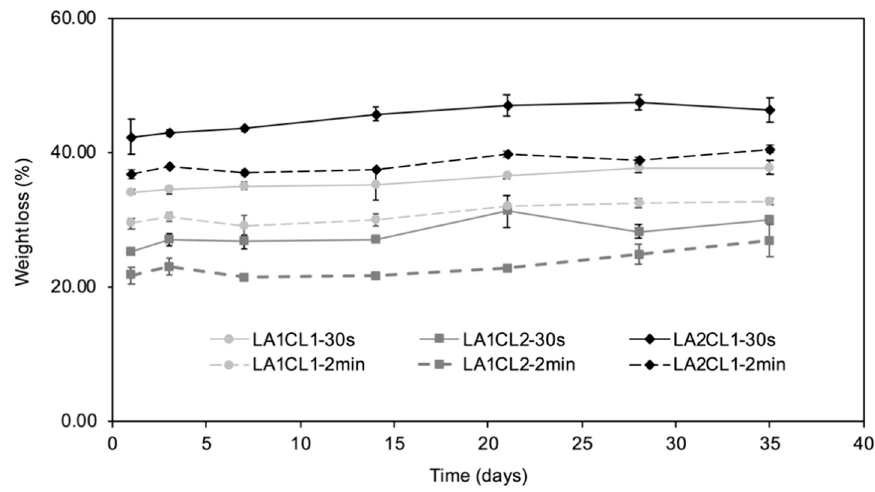
Figure 5. Weight loss (%) of the produced adhesives over 5 weeks.